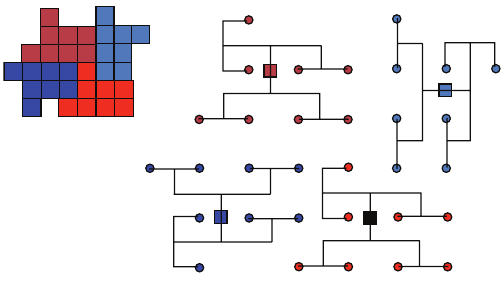
Figure 7: Point-up power divider and array section.